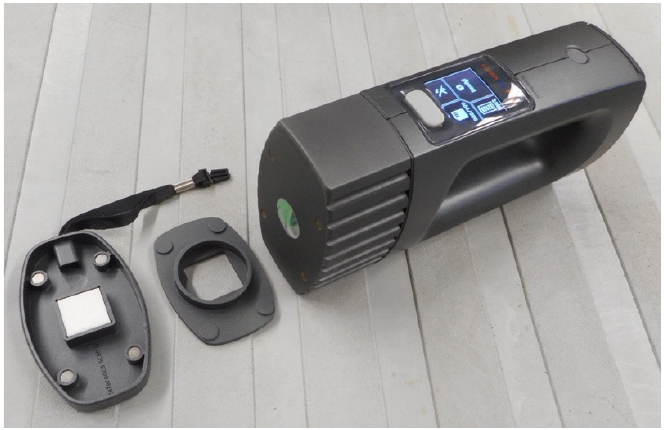
Figure 1. NeoSpec-Scanner, sample holder, and white